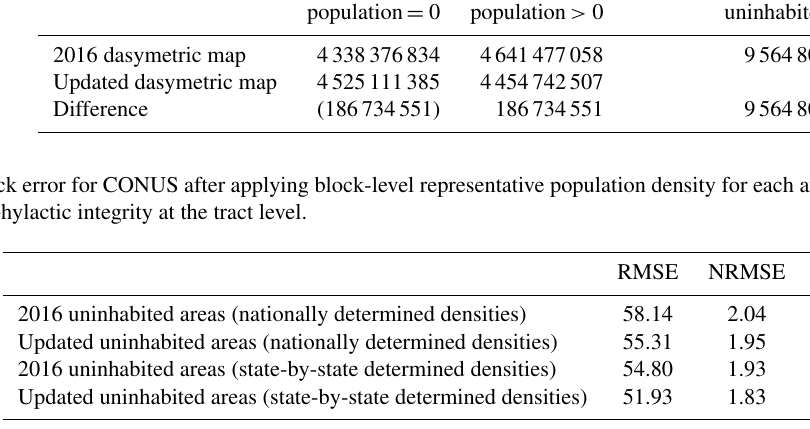
Table 4. Count of pixels with and without population using the 2016 specification of uninhabited and the updated specification of uninhabited. Note that counts include pixels within zero population blocks. Pixels with Pixels with